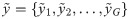
Effects of cancer specific mutations on a normal exome modeled as a cancer channel.Cancer exome y˜={y˜1,y˜2,…,y˜G} is obtained from normal exome y = {y1, y2, …, yG} through a cancer specific probabilistic transformation Pc,ρ(β|α) which assigns to each nucleotide α the probability of being mutated to nucleotide β. This transformation depends on both the mutation distribution specific to cancer c and the mutation rate ρ.